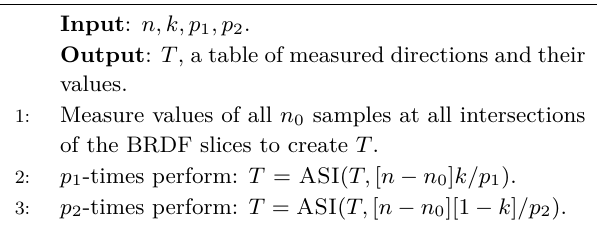
Algorithm 1 Algorithm for adaptive sampling along the slices